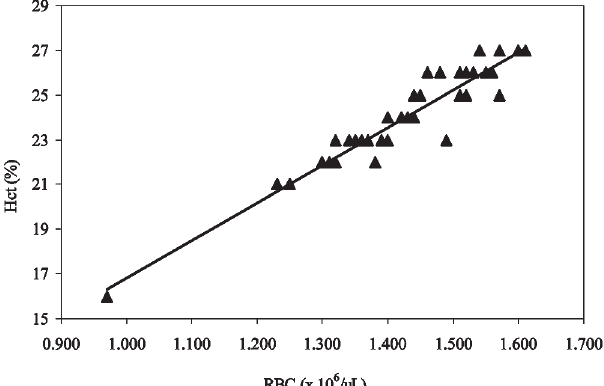
Fig. 3. Relationship between hematocrit and red blood cells ( r = 0.950; p<0.001) in C . temensis (n = 40) farmed in central Amazon.